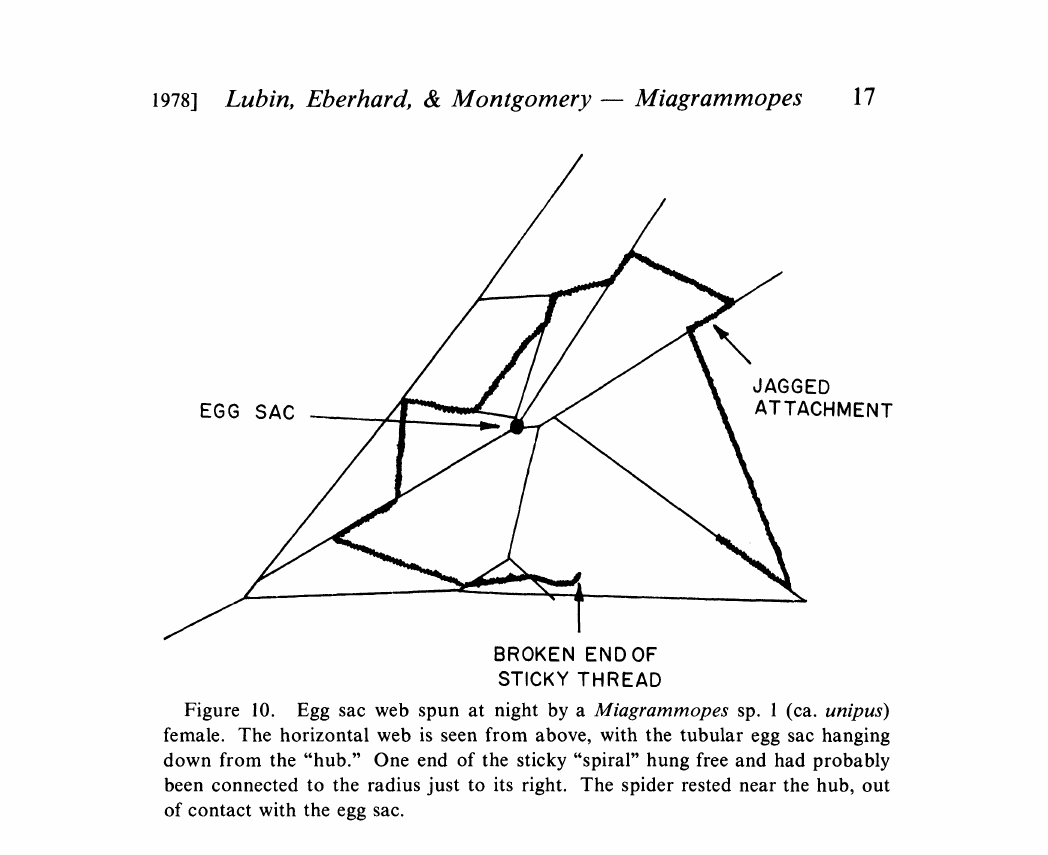
Figure 10. Egg sac web spun at night by a Miagrammopes sp. (ca. unipus) female. The horizontal web is seen from above, with the tubular egg sac hanging down from the "hub." One end of the sticky "spiral" hung free and had probably been connected to the radius just to its right. The spider rested near the hub, out of contact with the egg